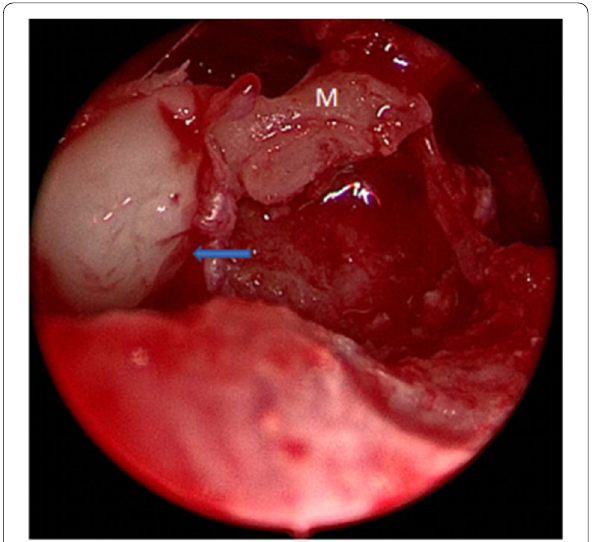
Fig. 2 Endoscopic view of the limits of the posterior extension of the cholesteatoma sac in the posterior attic. M. head of the malleus after removal of the necrosed incus, arrow: refers to the posterior limit of cholesteatoma